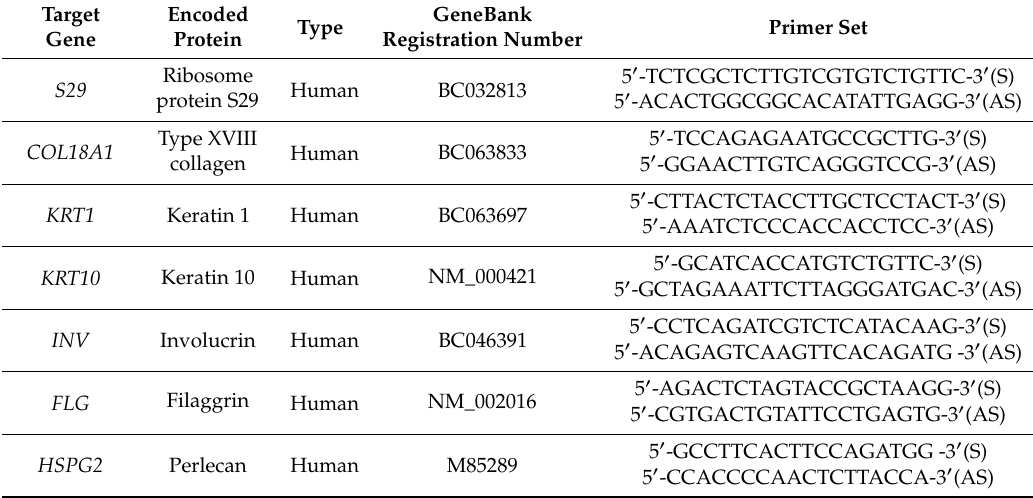
Table 1. The base sequence of the primers used for RT-PCR. S: sense, AS: